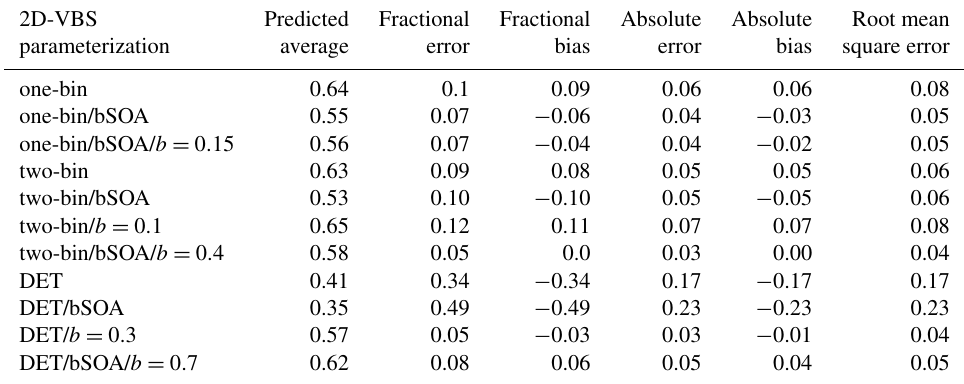
Table 2. Performance metrics of different parameterizations during the PEGASOS campaign for ground O : C measurements. The measured average O : C was 0.58.